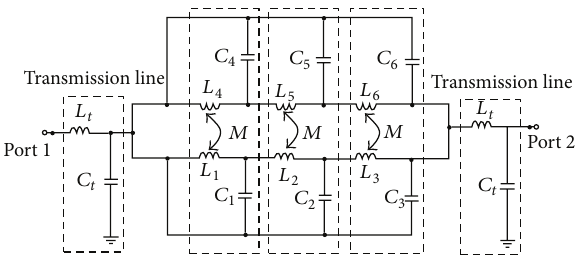
Figure 3: Equivalent circuit model of the symmetric TBBSF.